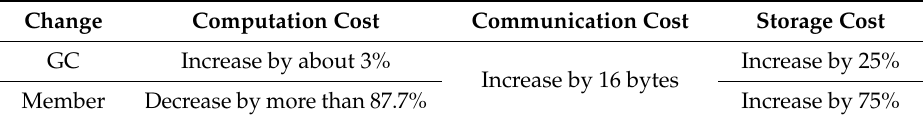
Table 6. Cost of CEGKD compared with